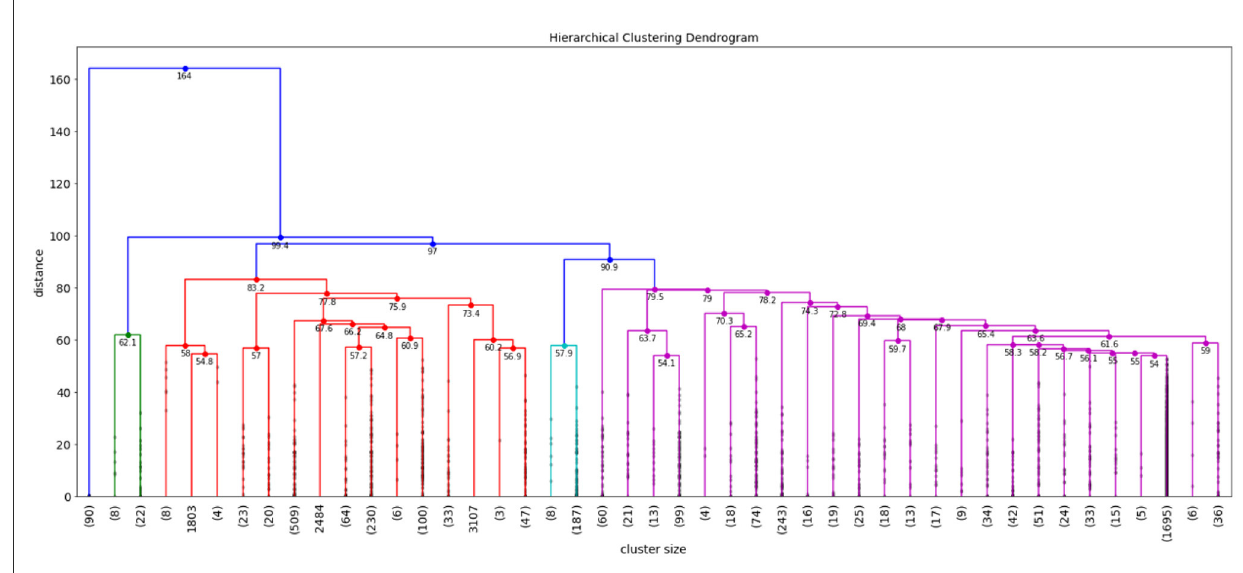
FIGURE3 Example of dendrogram for NIH clinical reports indication super-category.